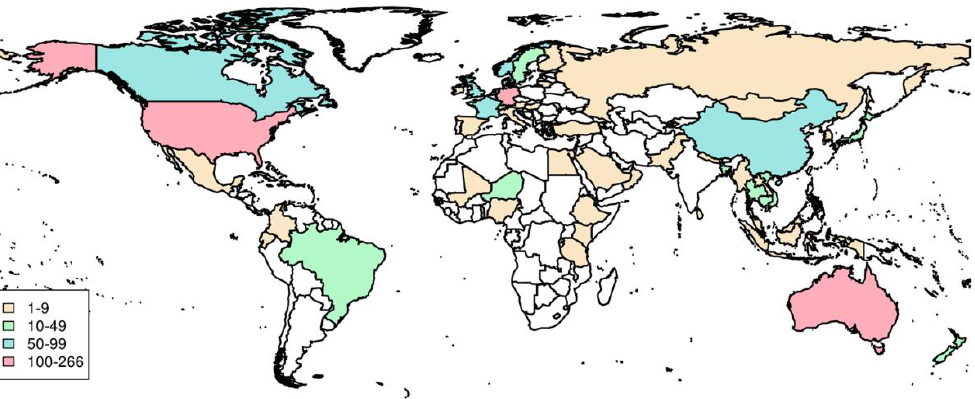
Figure 1. Map of epidemiological distribution of E. coli ST38 based on available metadata from EnteroBase.